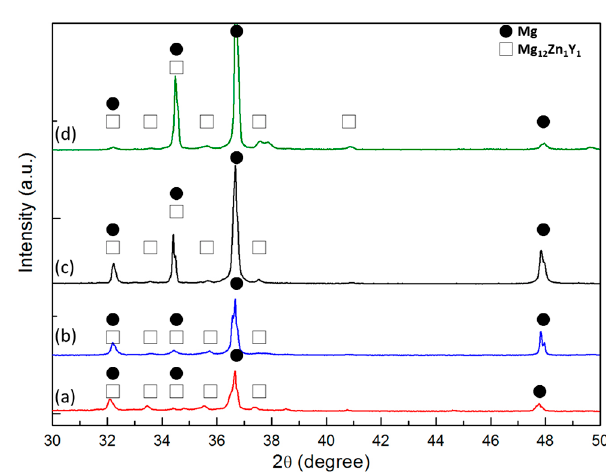
Figure 3. X-ray diffraction (XRD) patterns of ( a ) MgZnY-C; ( b ) HA-C; ( c ) MgZnY-T and ( d ) HA-T alloys.